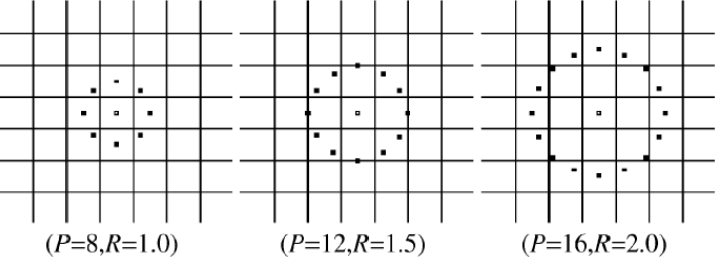
Figure 2. An example of the extended LBP with different ( P , R